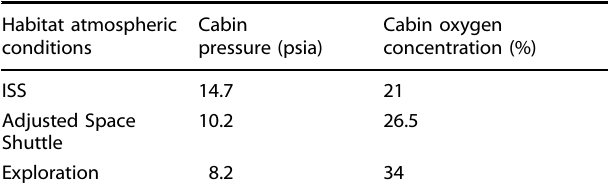
Table 2. The habitat atmospheric conditions (pressure and oxygen concentration) considered in the present